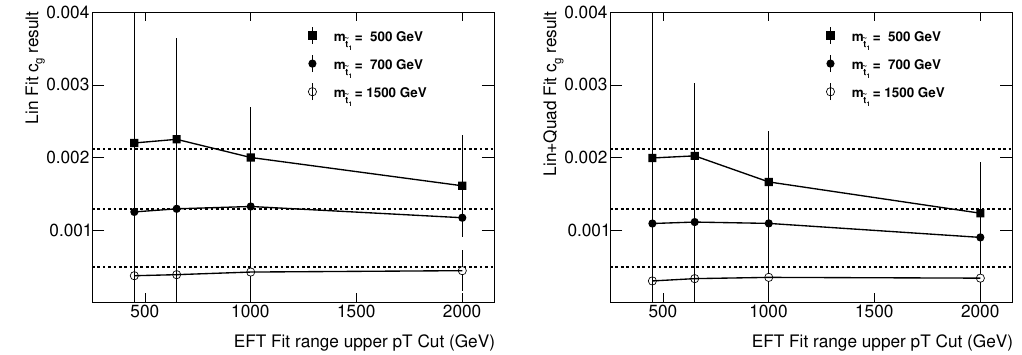
Figure 6. Wilson-coefficient c g values obtained with only linear (left) and with linear plus quadratic terms (right) to p H spectra produced from MSSM-like benchmark scenarios with different T m ˜ values as a function of the upper end of the p H fit range. The dashed lines show the c g values t 1 T of the SMEFT matching to the MSSM-like benchmark